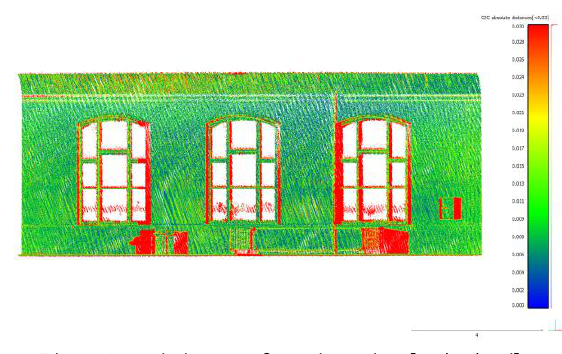
Figure 4 Deviation map for Leica point cloud - details